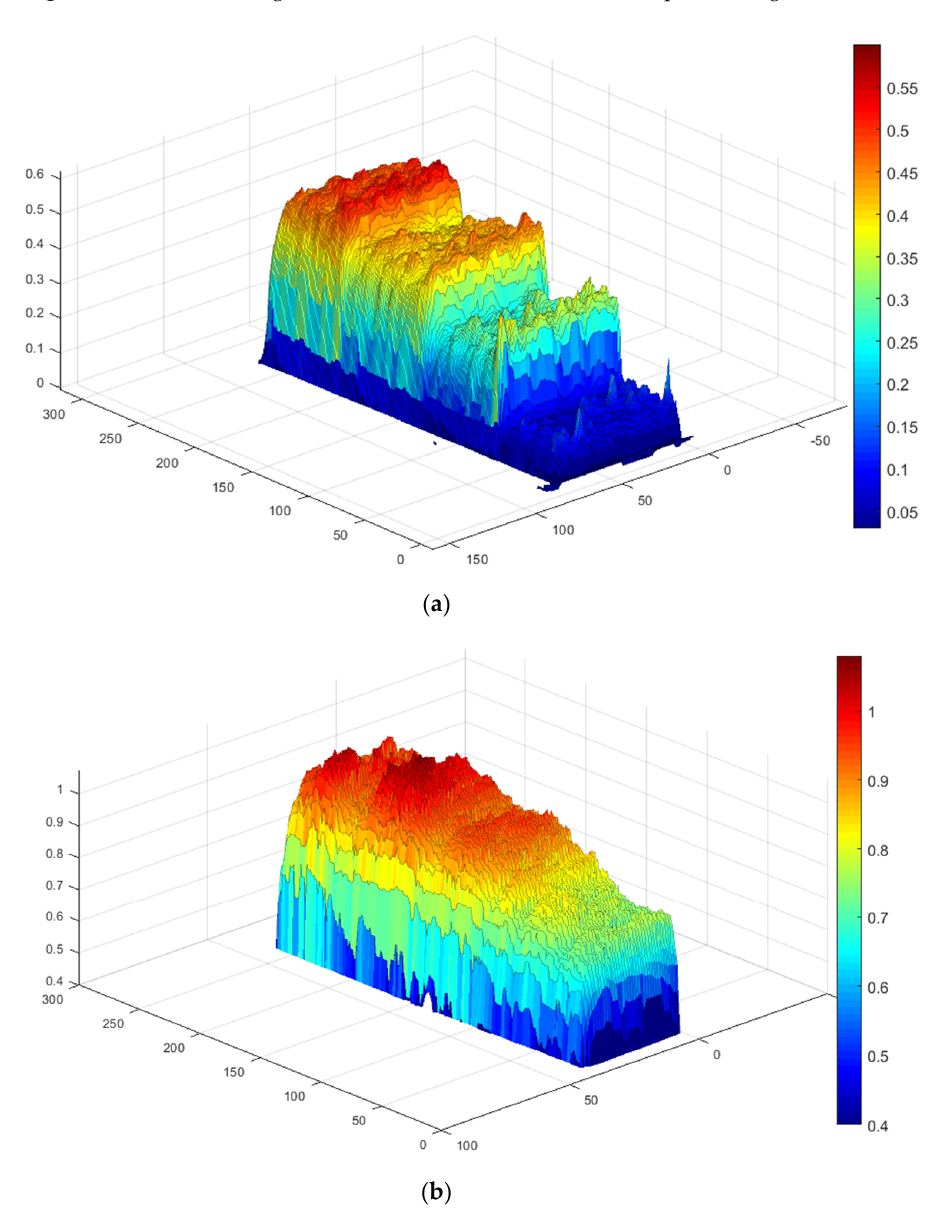
Figure 10. Three-dimensional coating thickness maps: ( a ) sample 1, ( b ) sample